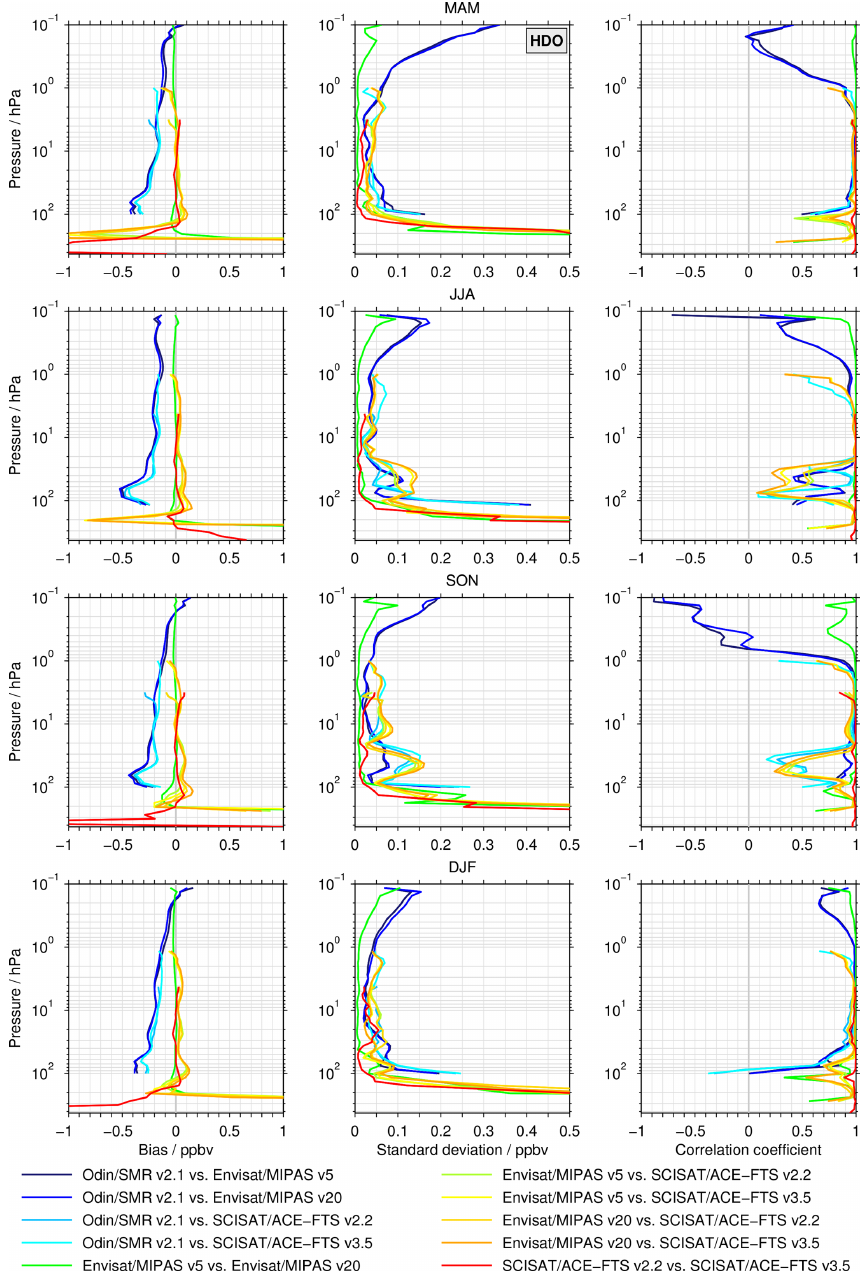
Figure 8. As for Fig. 7 but for HDO.